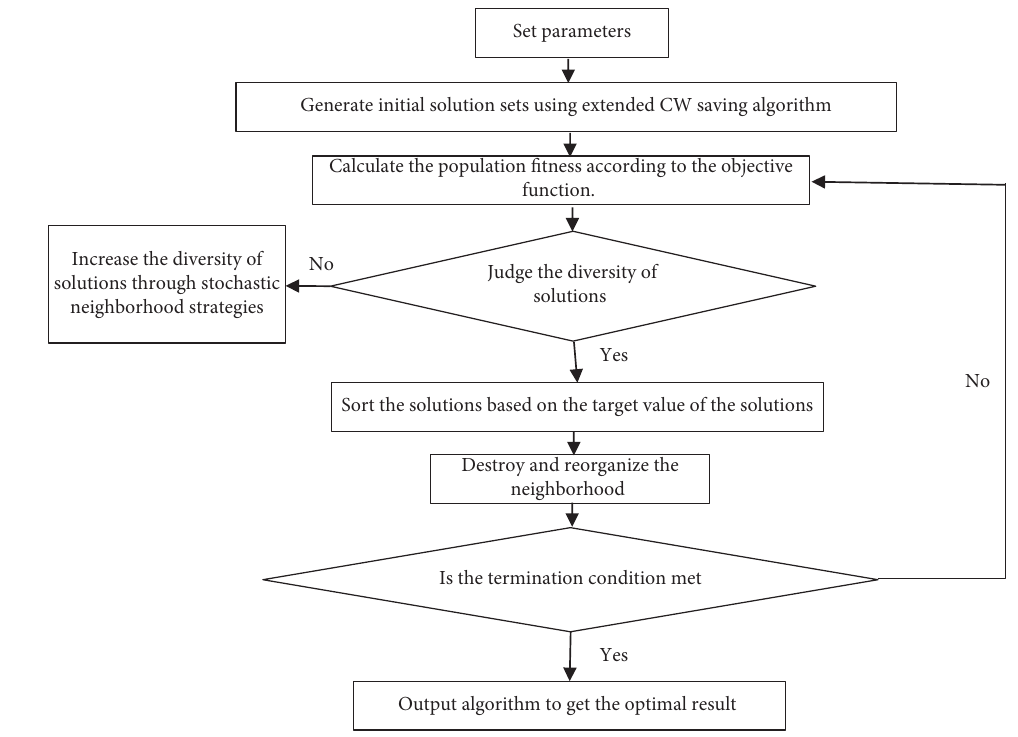
Figure 5: Optimized adaptive genetic algorithm solution process.